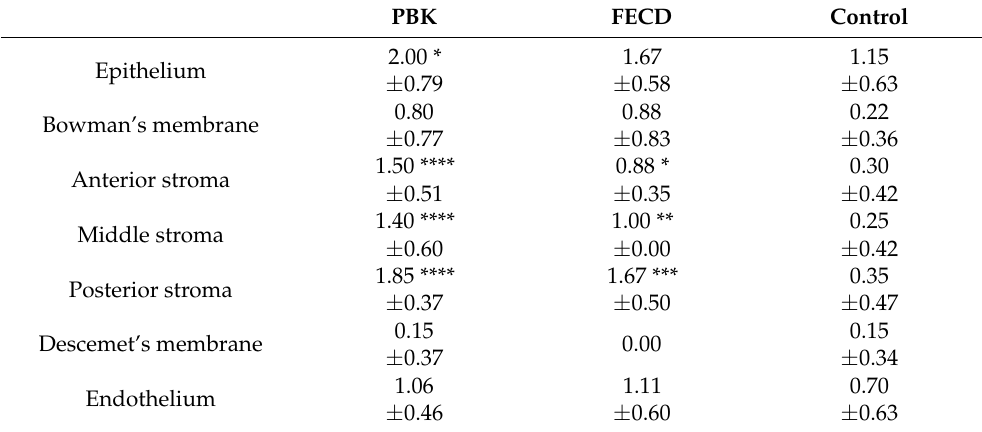
Table 3. Tenascin-C immunopositivity in the different corneal layers in normal and pathologic conditions. PBK FECD Control